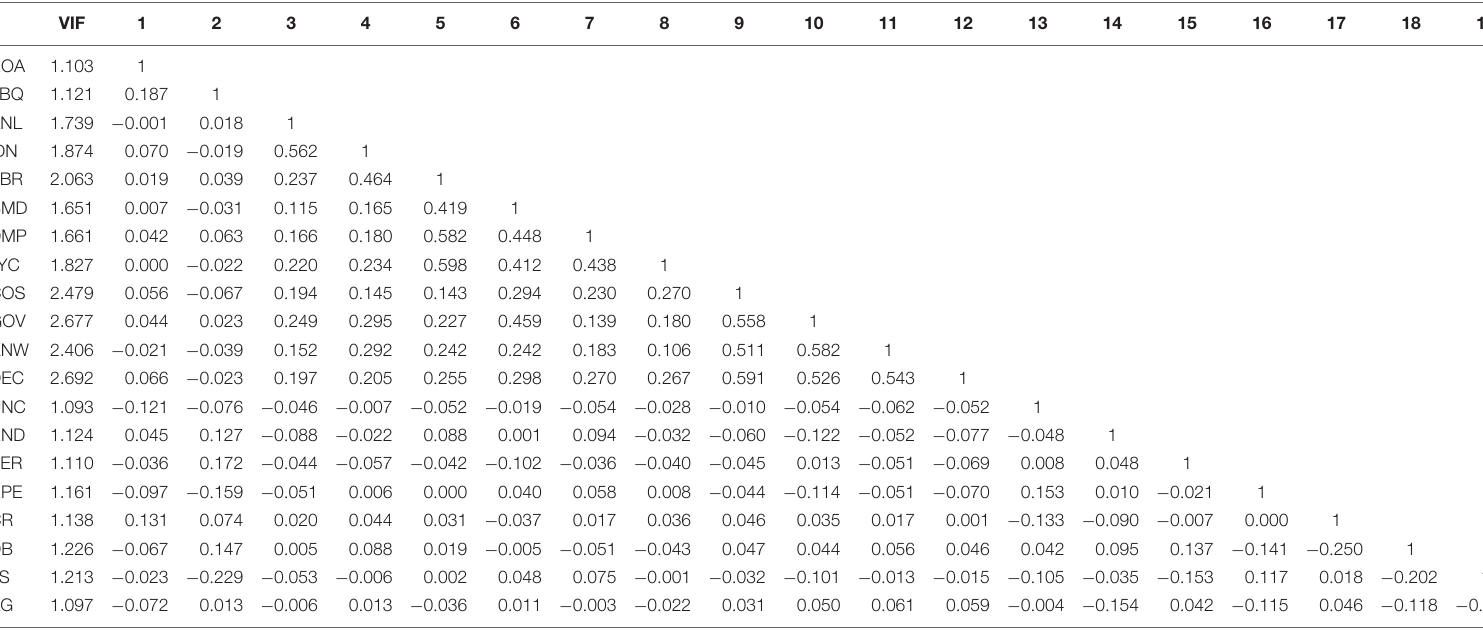
TABLE 4 | Bivariate correlations matrix.